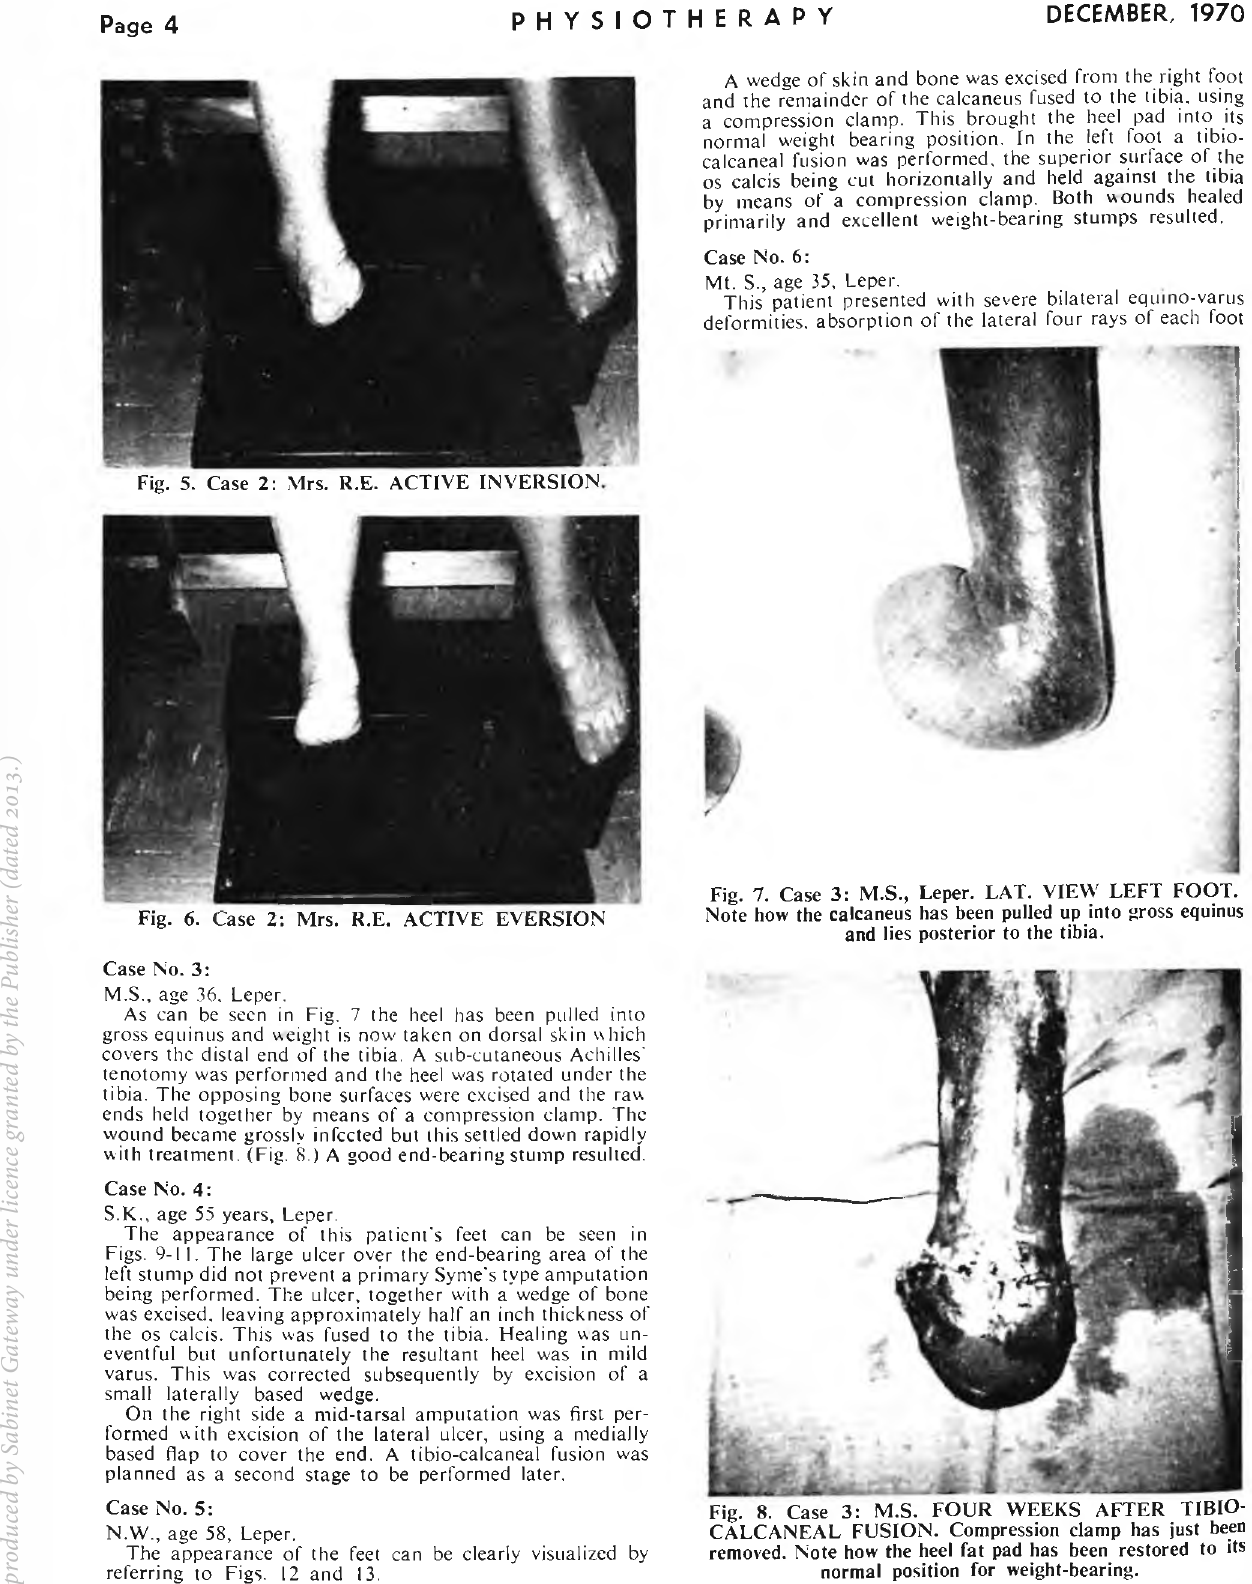
Fig. 8. Case 3: M.S. FOUR WEEKS AFTER TIBIO- CALCANEAL FUSION. Compression clamp has just been removed. Note how the heel fat pad has been restored to its normal position for